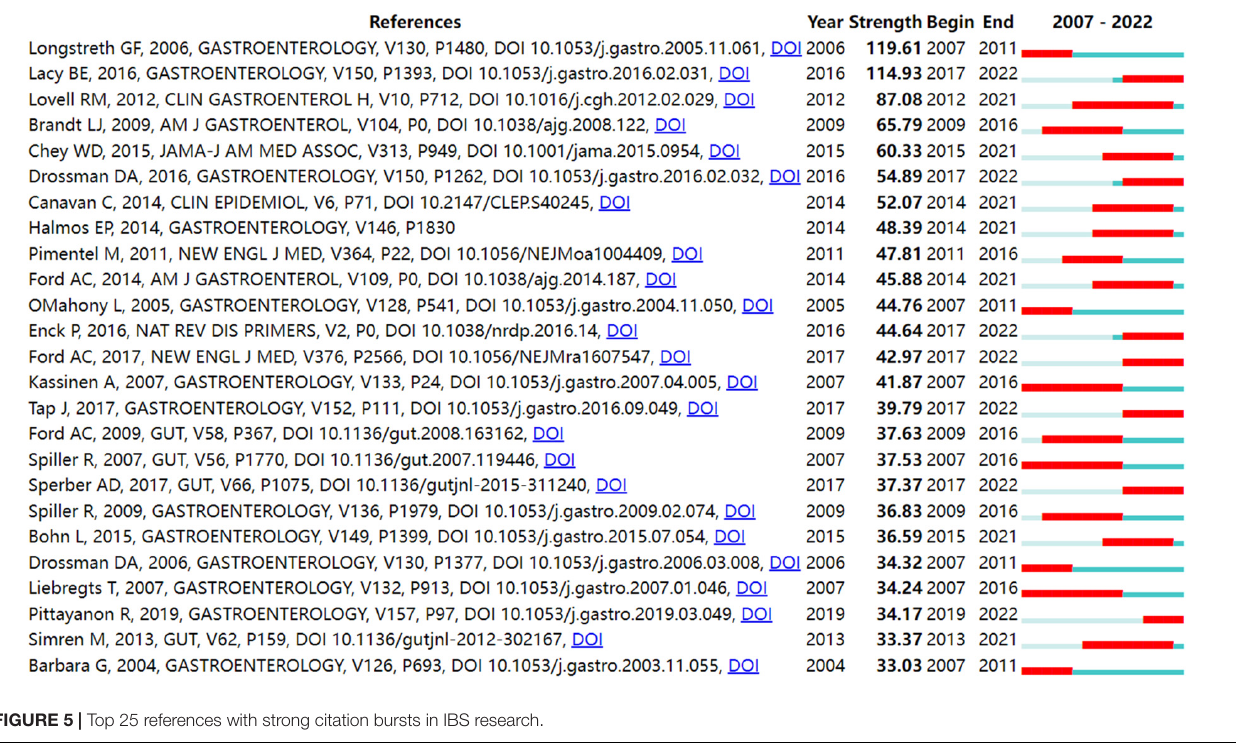
FIGURE 5 | Top 25 references with strong citation bursts in IBS research.